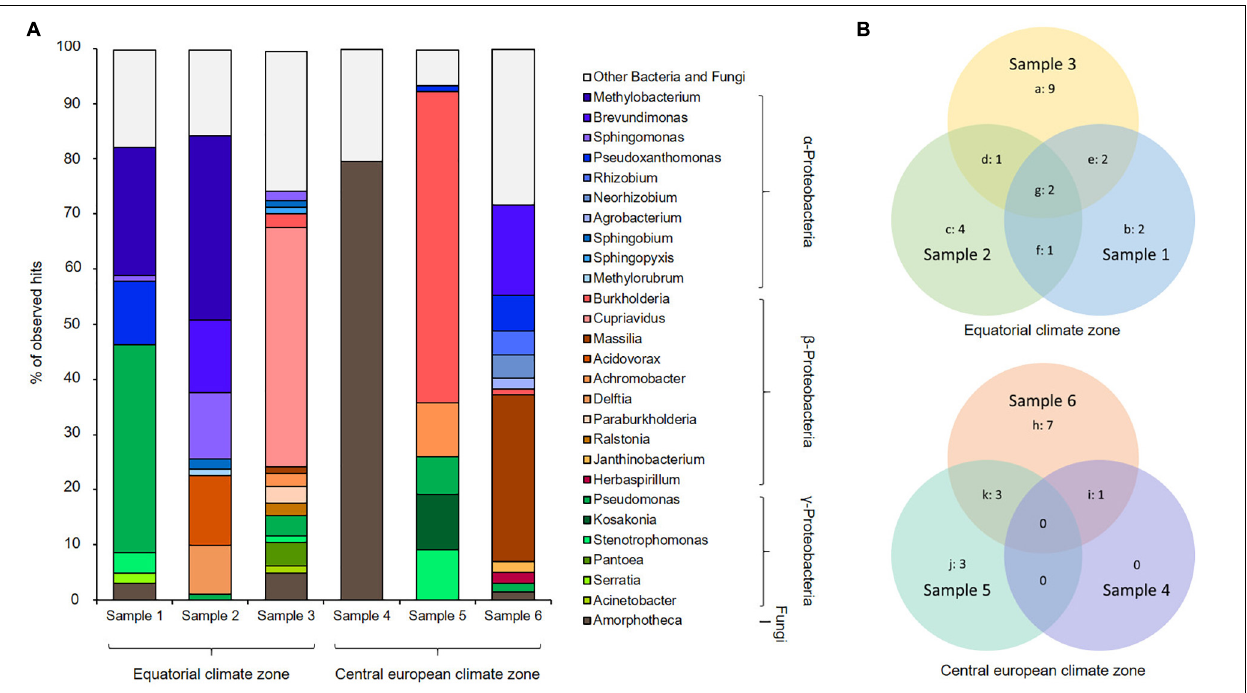
FIGURE 3 | Phylogenetic profiling of fuel biofilm-derived gene sequences based on Kraken2 analysis. (A) Metagenome stacked bar chart Kraken2, cutoff 1%, (B) Venn diagram showing the number of bins affiliated with assumed organisms uniquely, and the overlap of organisms within particular relationships using the Kraken2 dataset; digits indicate number of organisms a: Cupriavidus, Acinetobacter, Burkholderia, Paraburkholderia, Sphingopyxis, Pantoea, Massilia, Ralstonia, Achromobacter , b: Serratia, Pseudoxanthomonas, c: Acidovorax, Delftia, Methylorubrum, Brevundimonas , d: Sphingobium , e: Amorphotheca, Stenotrophomonas